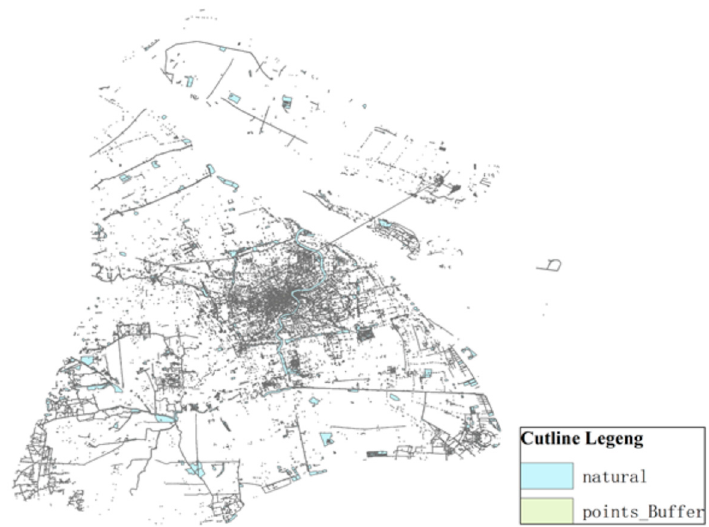
Figure 7. Residential land buffer zone.